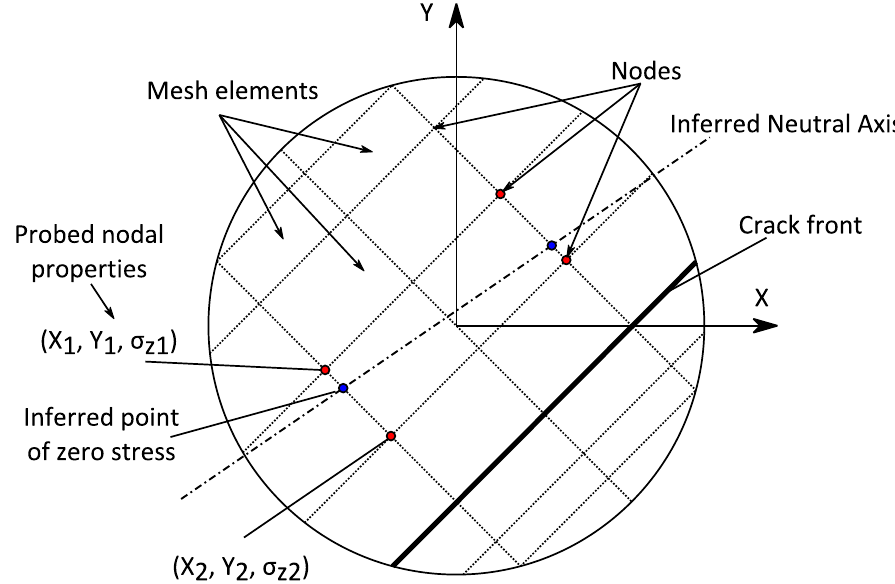
Figure 5. Neutral plane inference based on pairs of nodes on the same element edge with oppositely signed normal stress.